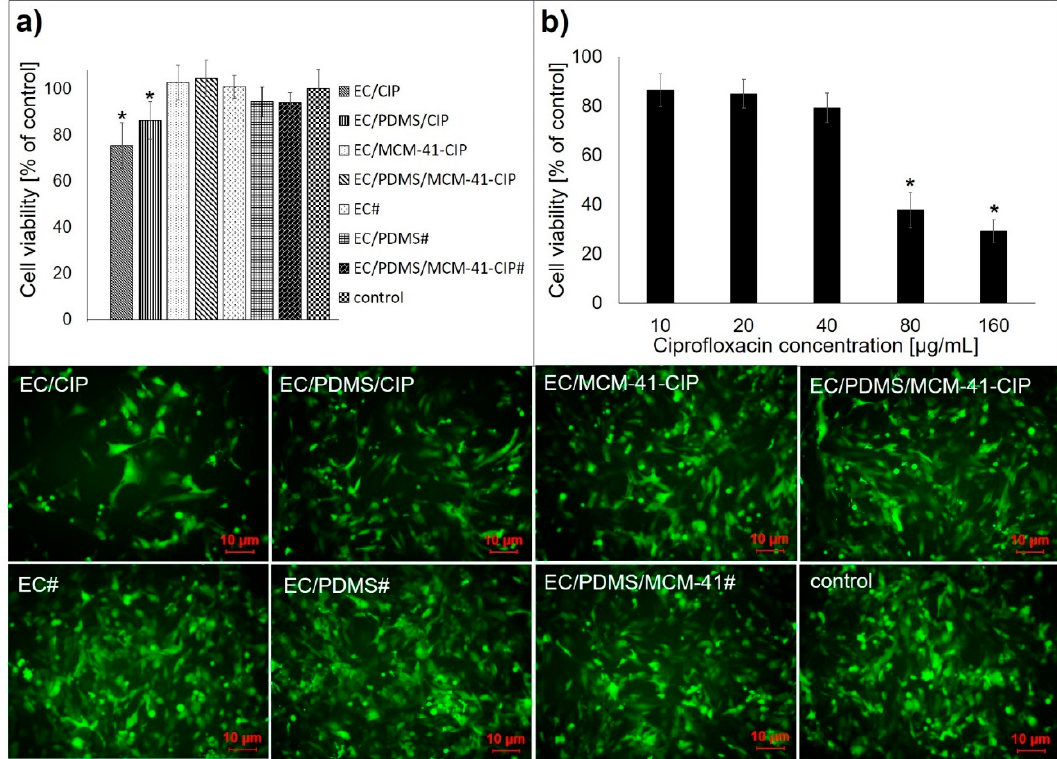
Figure 6. The effect of the composites (EC/CIP, EC/PDMS/CIP, EC/MCM-41-CIP, EC/PDMS/MCM-41-CIP) and CIP-free analogues (EC#, EC/PDMS#, EC/PDMS/MCM-41#) on osteoblasts viability ( a ); the effect of the various concentrations of CIP on osteoblasts viability ( b ). Data is represented as mean ± SD ( n = 3). * p < 0.05 was considered statistically significant.